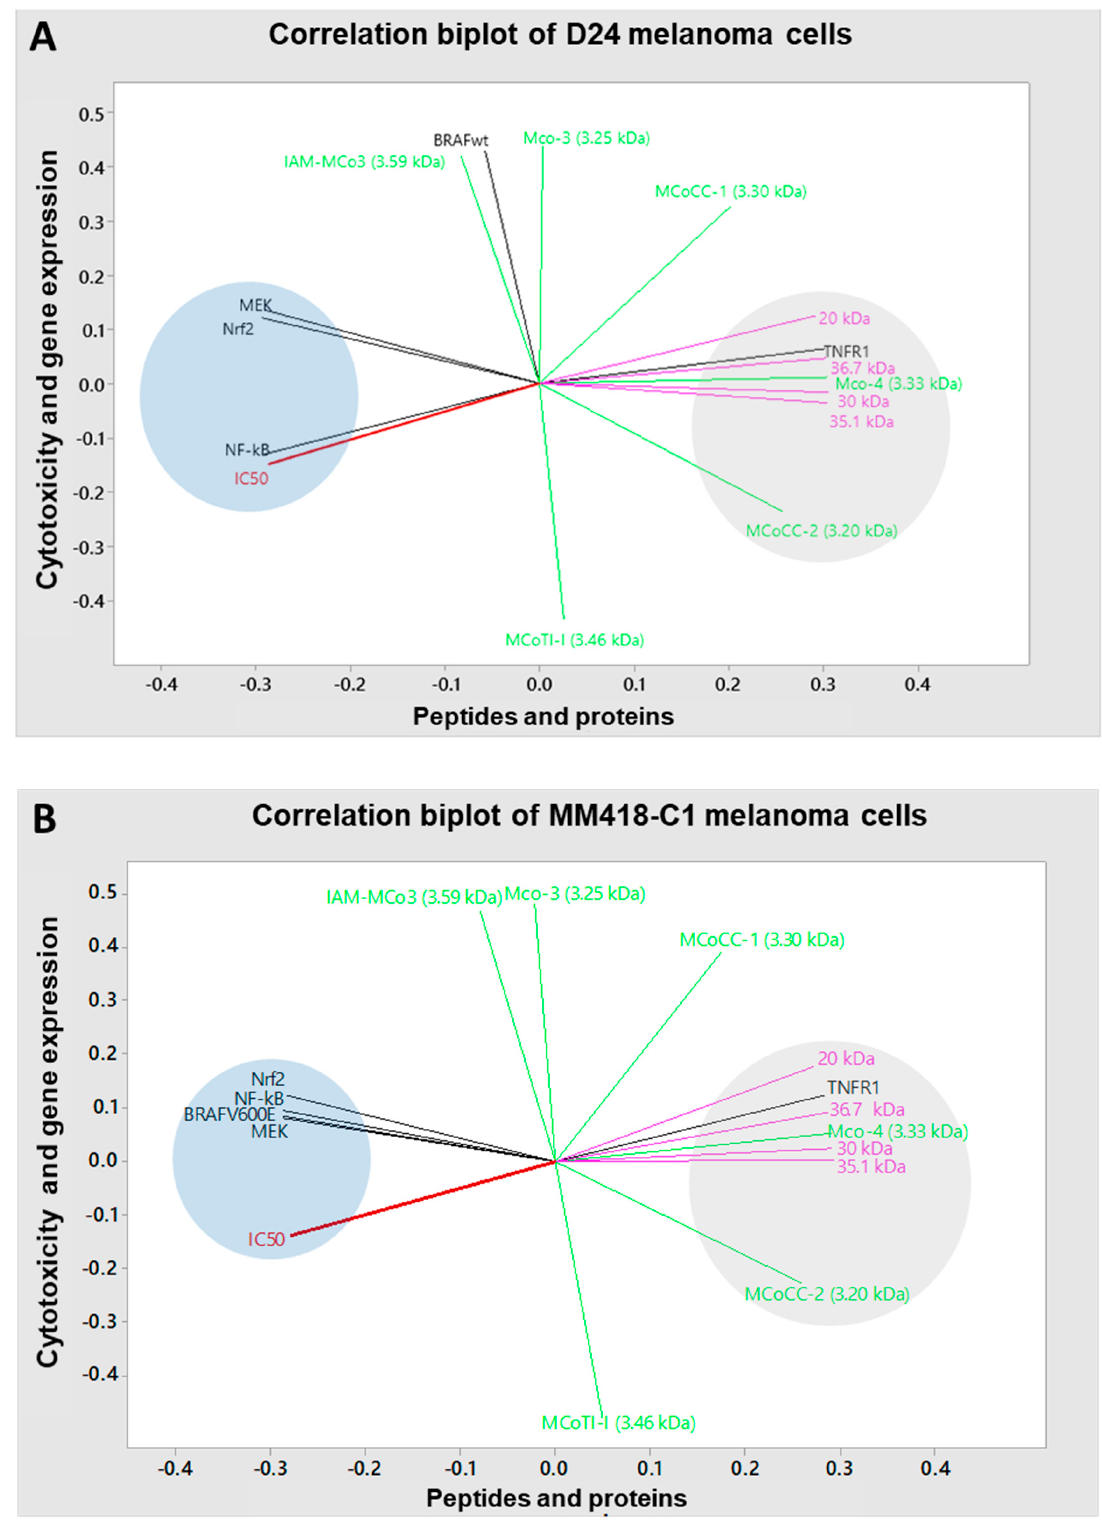
Figure 8. Correlation biplot of cytotoxicity (IC50) and gene expression with M. cochinchinensis seed proteins and peptides in D24 ( A ) and MM418-C1 melanoma cells ( B ) constructed using the principal component analysis method (PCA) with Minitab statistical software (Version 18). Red = IC50, black = gene expressions, purple = proteins and green = peptides. In the MM418-C1 melanoma cells, cytotoxicity had a strong positive correlation with mRNA expression of MEK1 (0.90, p < 0.001), BRAF V600E (0.89, p < 0.001), NF-kB (r = 0.85, p < 0.001) and Nrf2 (r = 0.79, p < 0.001), as seen clustered together in the left quadrat (Figure 8B). These correlations indicated that cytotoxicity elicited by the seed extracts was